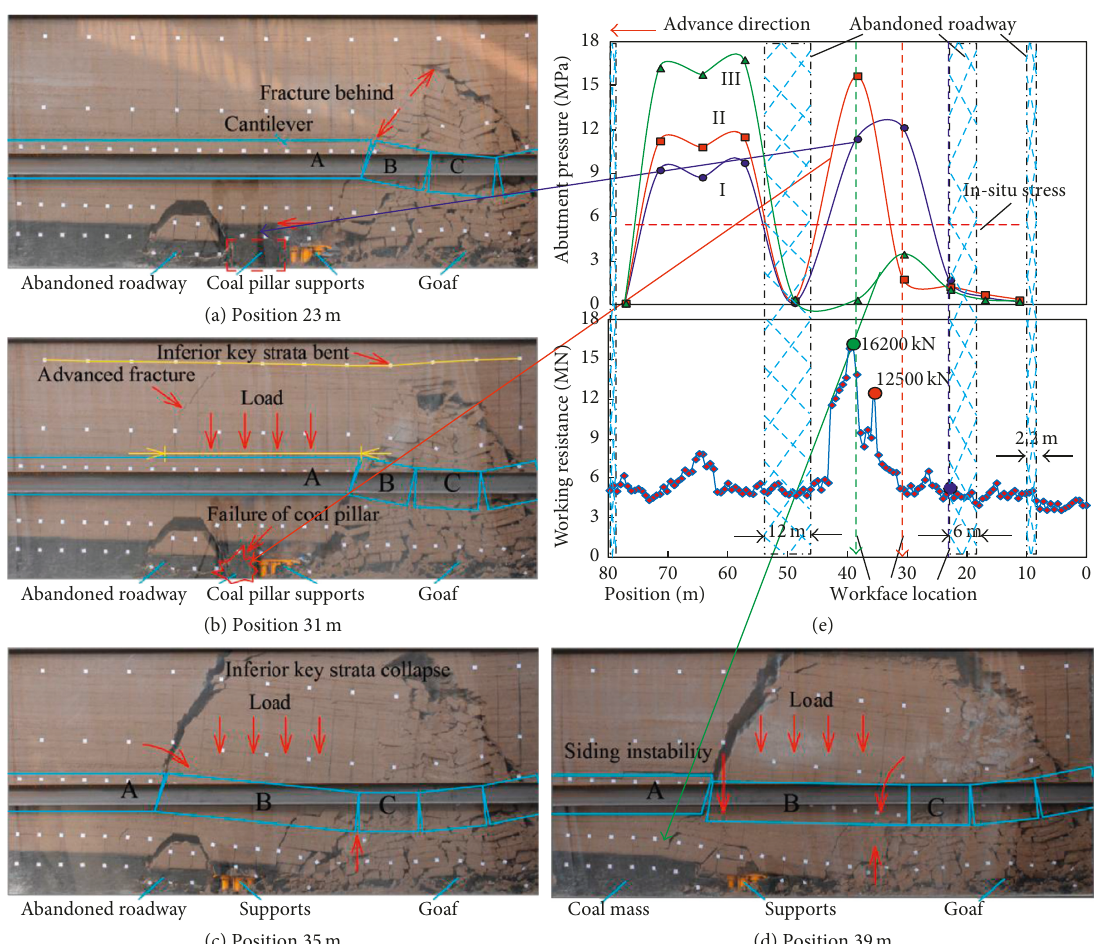
Figure 5: Result of the 2D similar simulation. (a) Position 23m, (b) position 31 m, (c) position 35 m, and (d) position